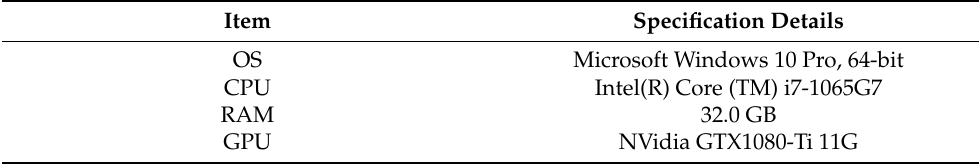
Table 3. Hardware specifications of the neural network computer.